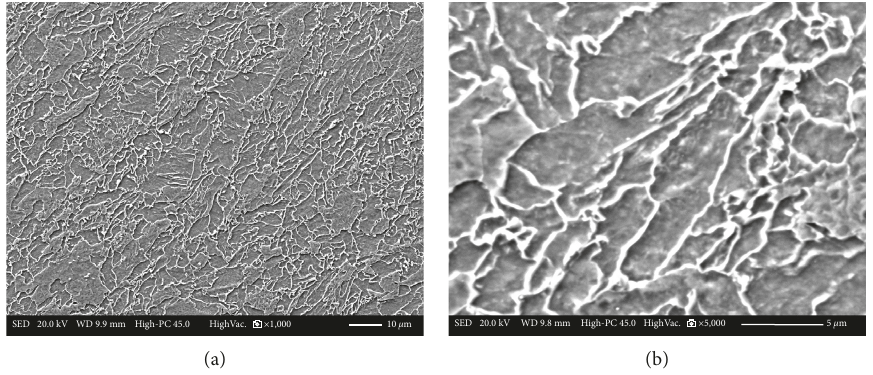
Figure 10: Microstructure of the API X70 steel as received at different magnifications.